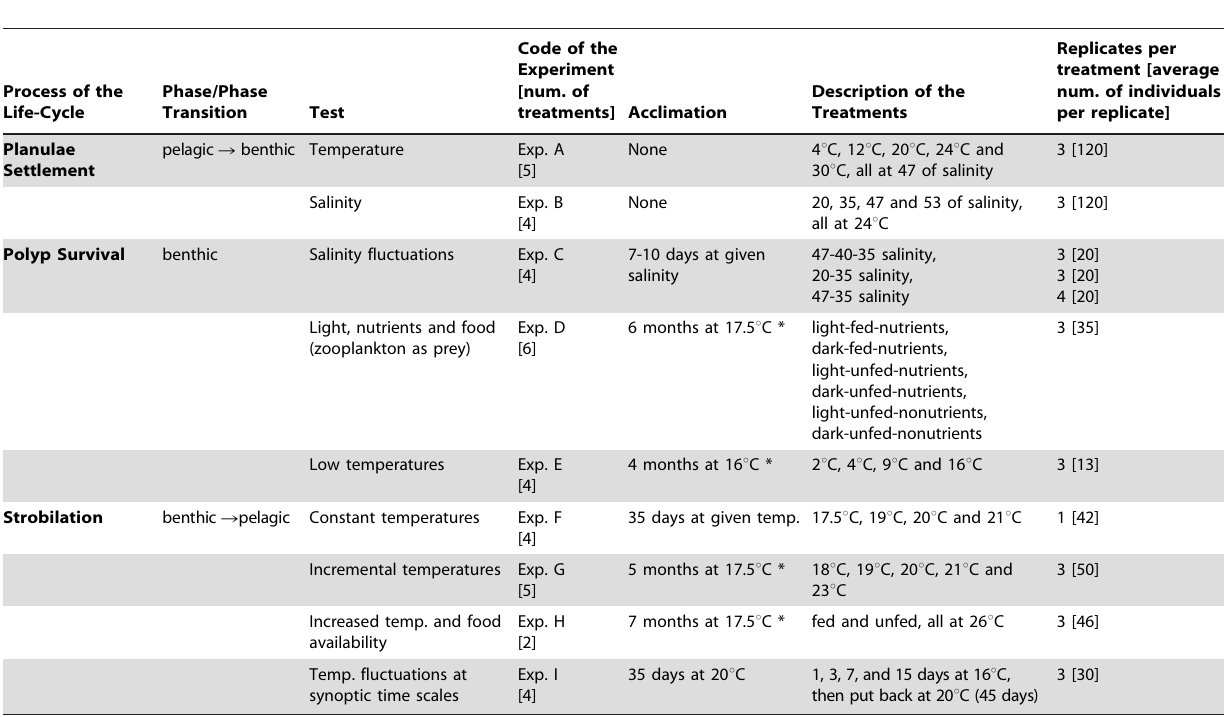
Table 1. Summary of the different experiments performed on the life cycle of Cotylorhiza tuberculata .